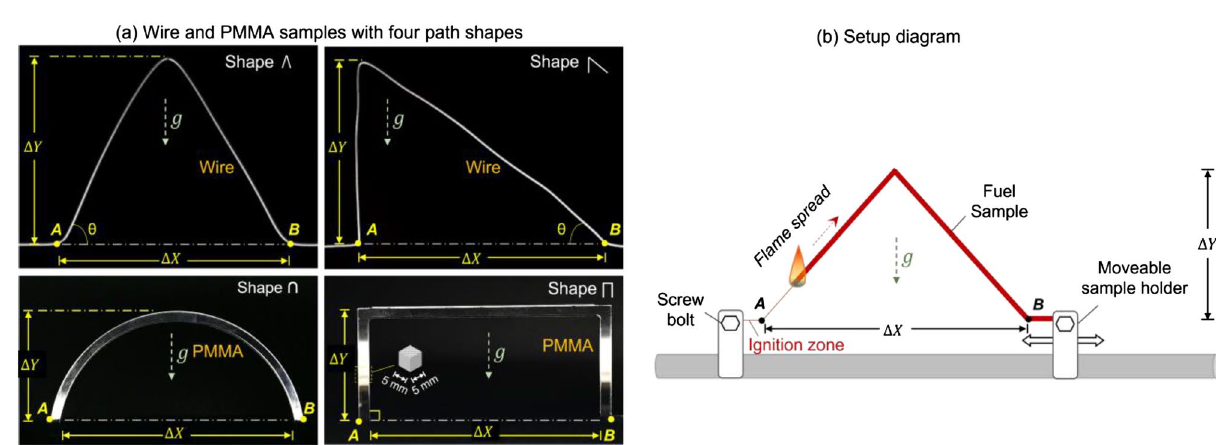
Figure 2. ( a ) Tested thin wires and thick PMMA bar with four curve shapes and ( b ) diagram of the experimental